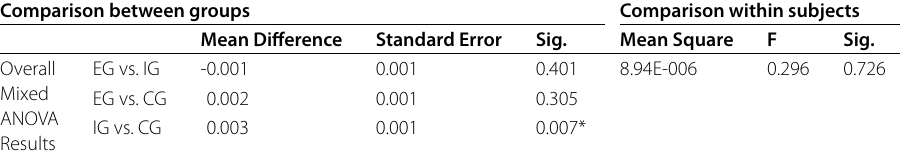
Table 6 Mixed ANOVA results for directives (normalized values) Comparison between